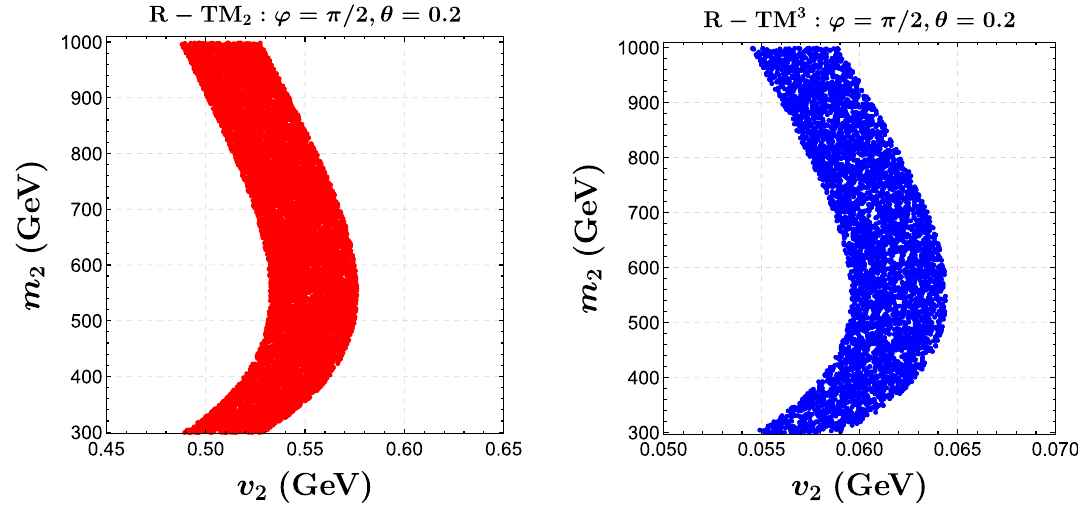
Fig. 7 The (v 2 , m 2 ) dependence of the baryon-number asymmetry Y R (cid:4) from Fig.